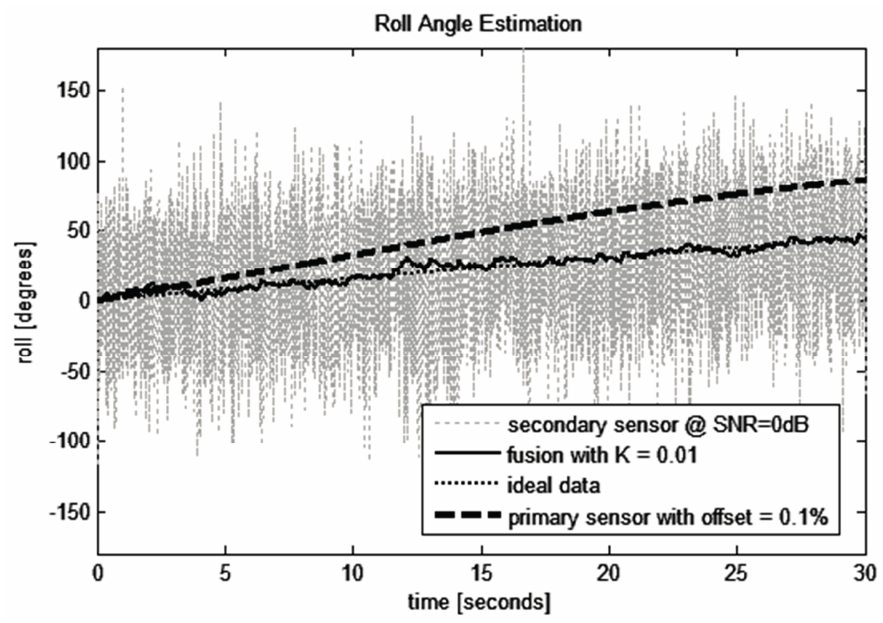
Figure 16. Estimation of roll angle with gyroscope offset 0.1% of full range